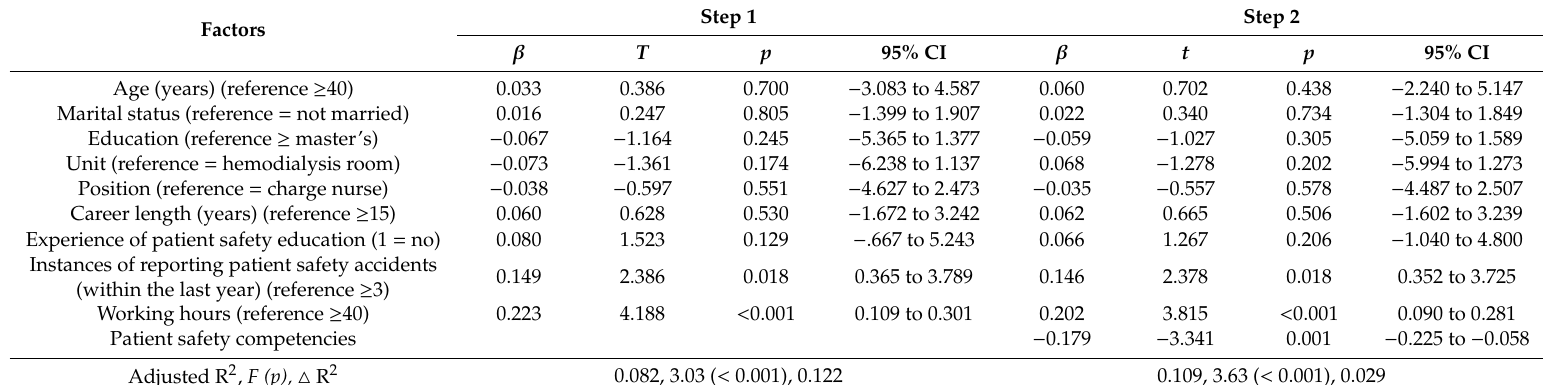
Table 3. Factors associated with adverse nurse outcomes ( N =